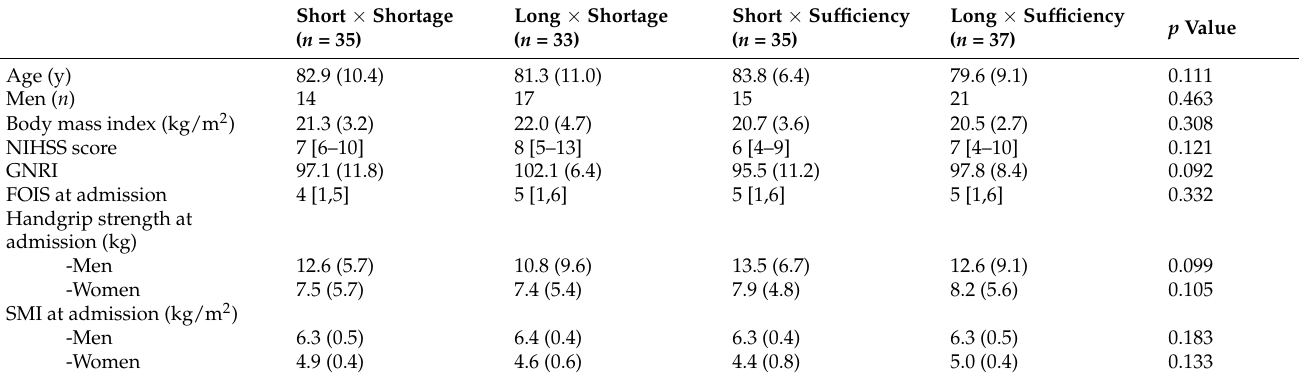
Table 2. Comparison of the clinical characteristics among the